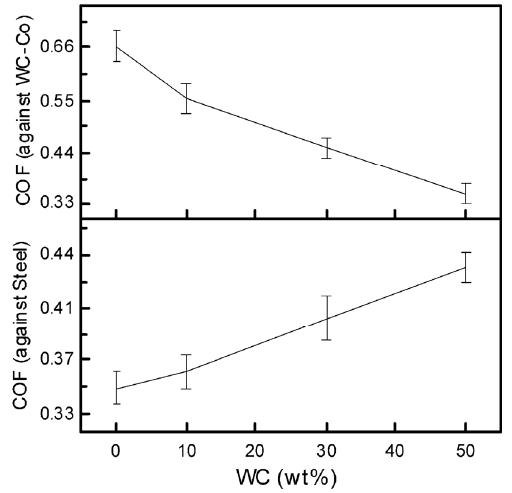
Fig. 3 Average coefficient of friction of SiC-WC composites against WC-Co and steel counterbodies at 20 N load.